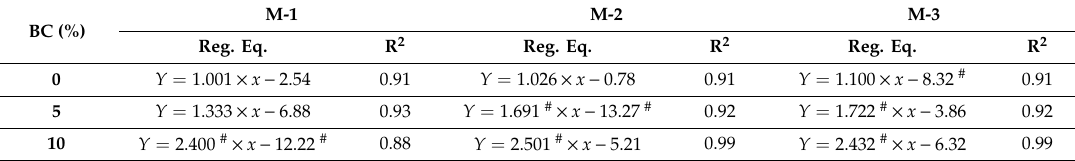
Table 5. Regression equations (Reg. Eq.) and coe ffi cients of determination (R 2 ) between measured and TDR-estimated volumetric soil moisture content (VSMC) for studied granular biochar (BC G ) rates (corresponding graphical representations are given in Figures 2–4). No data for BC G rates >